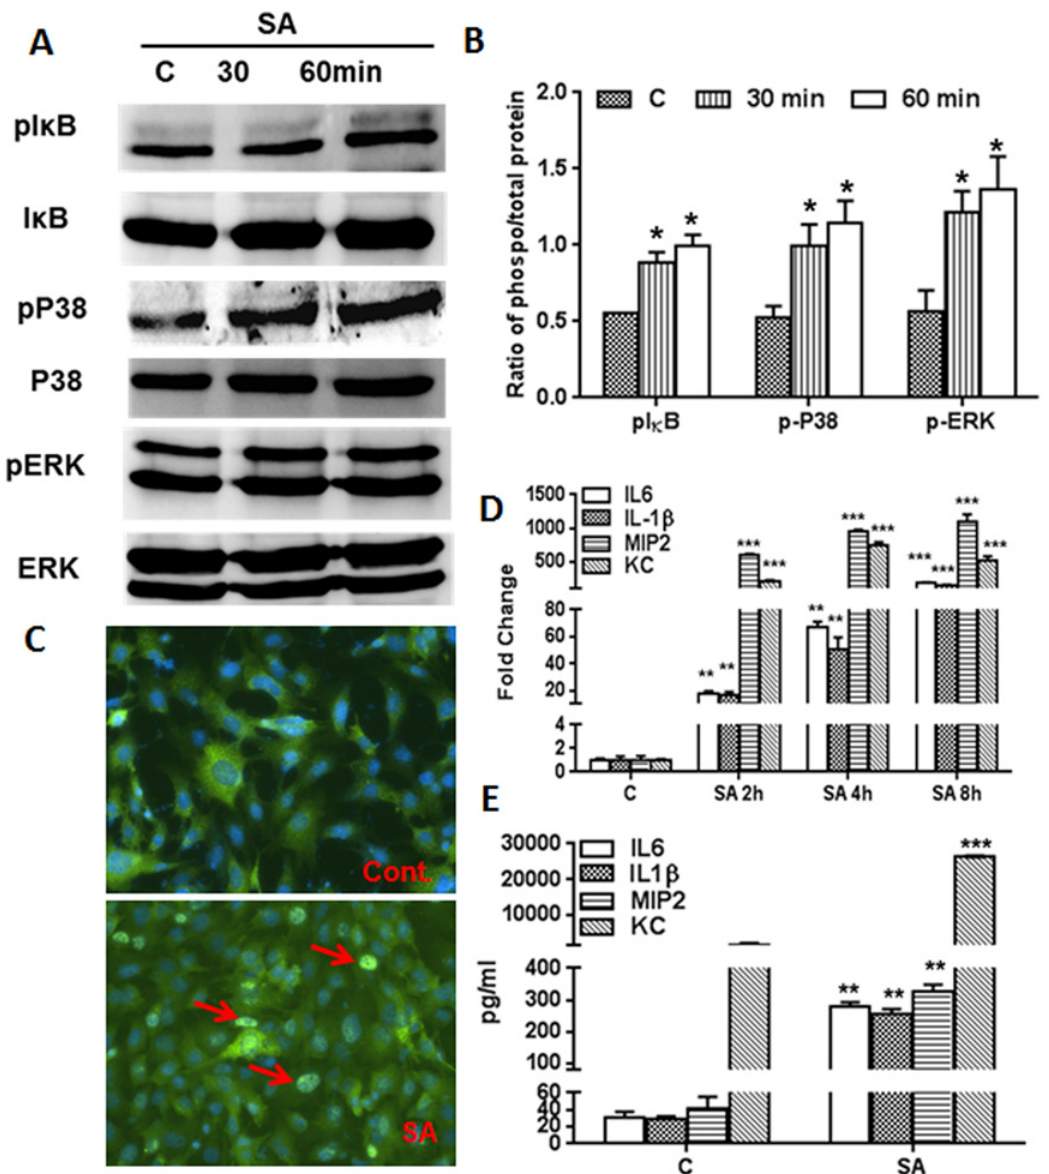
Fig 6. S. aureus-triggered innate responses in 661W cells. 661W cells were challenged with S . aureus (MOI 20:1) for the indicated time points and Western blot was performed for IkB, p38, and ERK using phosphorylated and non-phosphorylated antibodies (A). Band intensity was quantified using Image J (B). Immunostaining was performed to monitor the localization of NF-kB to the nucleus (C). qRT-PCR was performed for the quantification of induced mRNA expression of inflammatory mediators (IL-6, IL-1 β , CXCL1, and CXCL2) and the results were expressed as relative fold changes with respect to a GAPDH control (D). The level of secretary cytokines/chemokines was measured by ELISA (E). Data points and error bars represents mean ± SD of triplicates from two independent experiments. Statistical analysis was performed using one-way ANOVA ( * , p < 0.05; ** , p < 0.005; *** , p < 0.0005), for comparisons of control versus stimulated